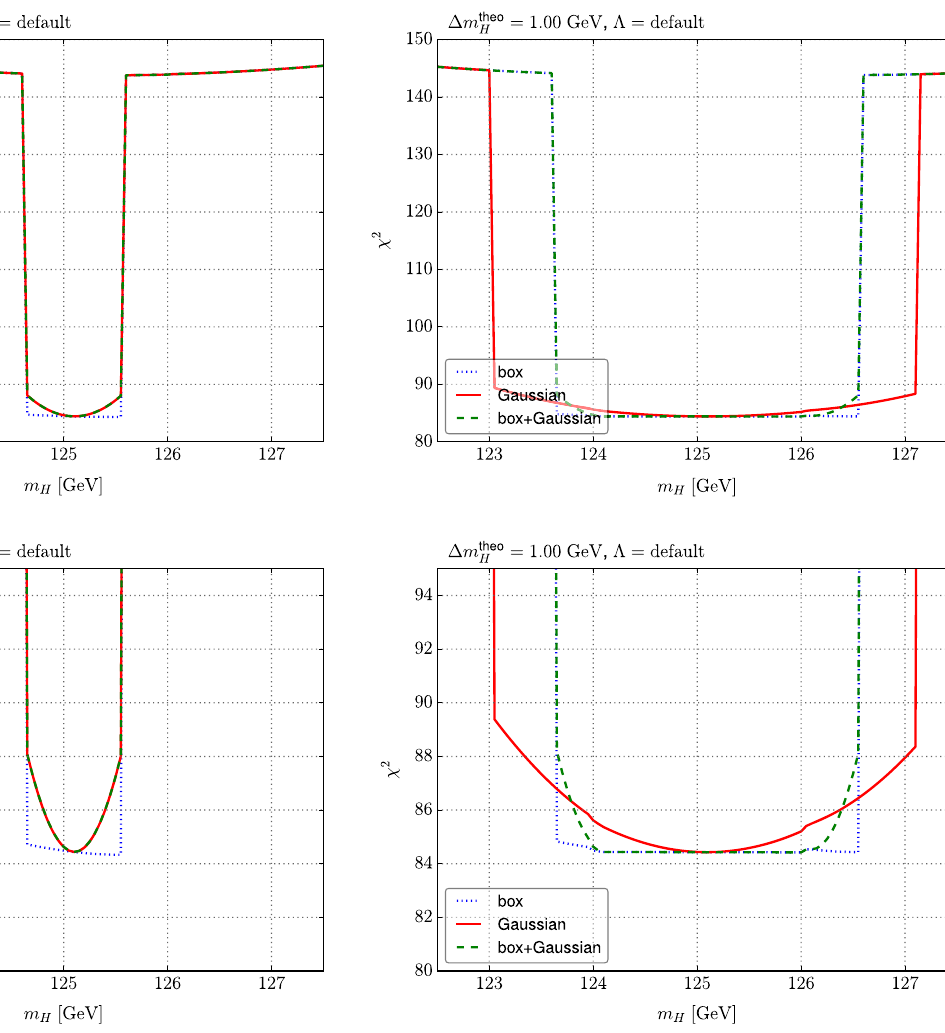
their default values (see text). The top panels show the χ 2 function in the full mass interval, whereas the bottom panels show a zoom to the region of the lowest χ 2